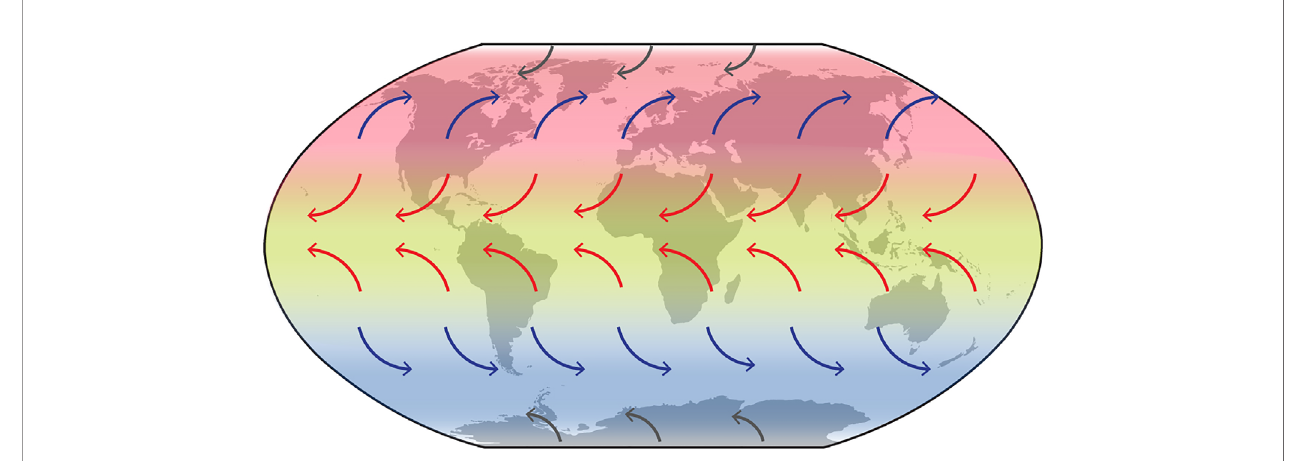
FIGURE 6 | Global wind patterns overlaying the distributions of the Southern Hemisphere (VI), Northern Hemisphere (VII), and tropical (II) clades (see Figure 2A ). Red arrows: Trade Winds; blue arrows: Westerlies; grey arrows: Polar